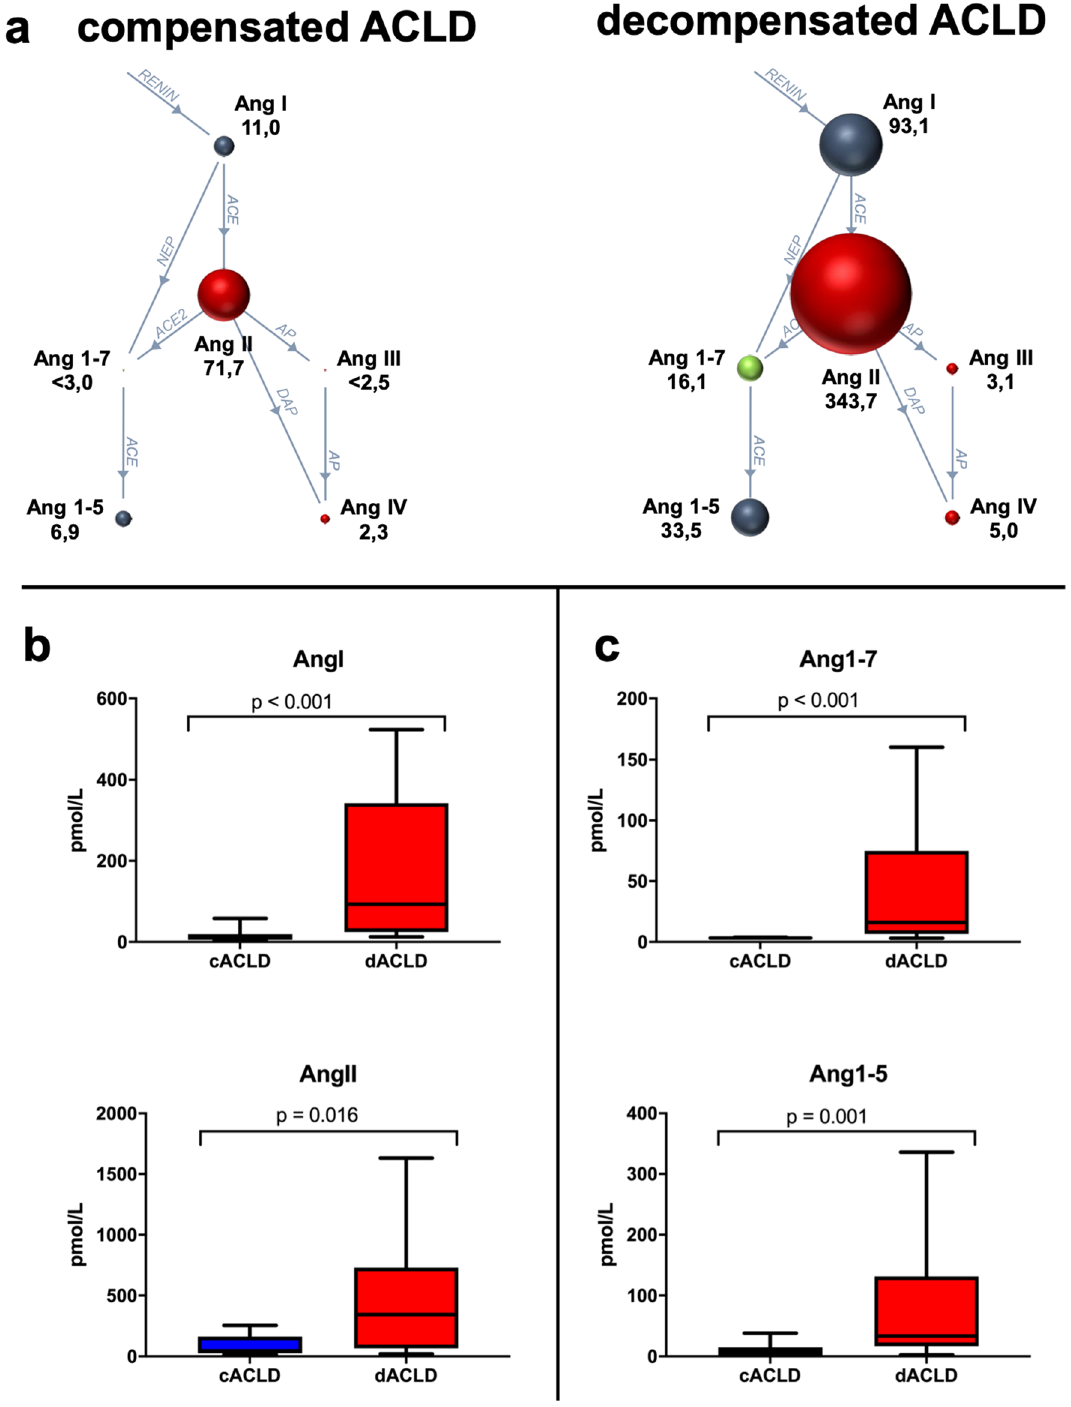
Figure 1. Components of the classical and alternative renin–angiotensin system (RAS) in patients with compensated (cACLD, n = 13) and decompensated cirrhosis (dACLD, n = 12). ( a ) Depiction of the RAS fingerprint in patients with cACLD and dACLD. Comparison of quantitative levels of ( b ) classical RAS components (Ang I and Ang II) and ( c ) alternative RAS components (Ang 1–7, Ang 1–5) between patients with cACLD and dACLD. For RAS fingerprint analysis, the size of the spheres and numbers beside them represent the median absolute concentrations of angiotensins (pmol/L) analyzed by mass spectrometry. Ang angiotensin, ACE angiotensin converting enzyme, AP aminopeptidase, cACLD compensated advanced chronic liver disease, dACLD decompensated advanced chronic liver disease, DAP dipeptidyl aminopeptidase, NEP neprilysin, RAS renin–angiotensin